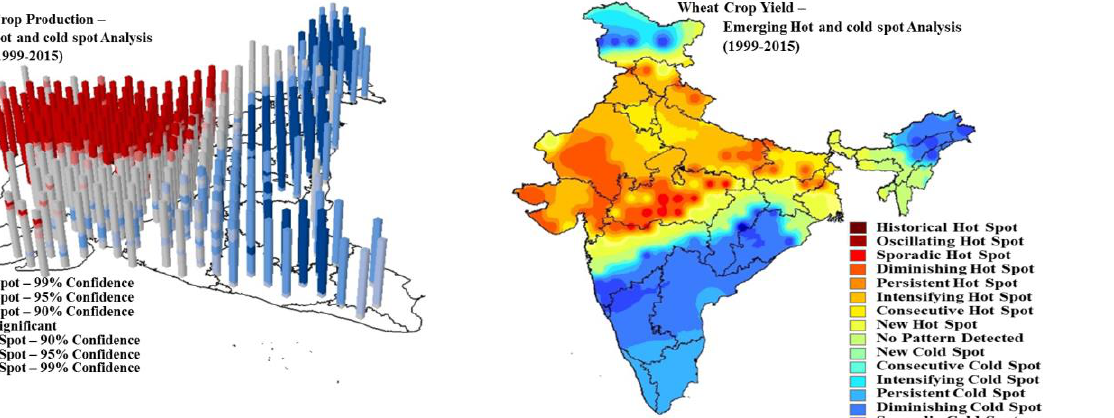
Figure 13 . Hot and cold spot map of change in wheat crop Production